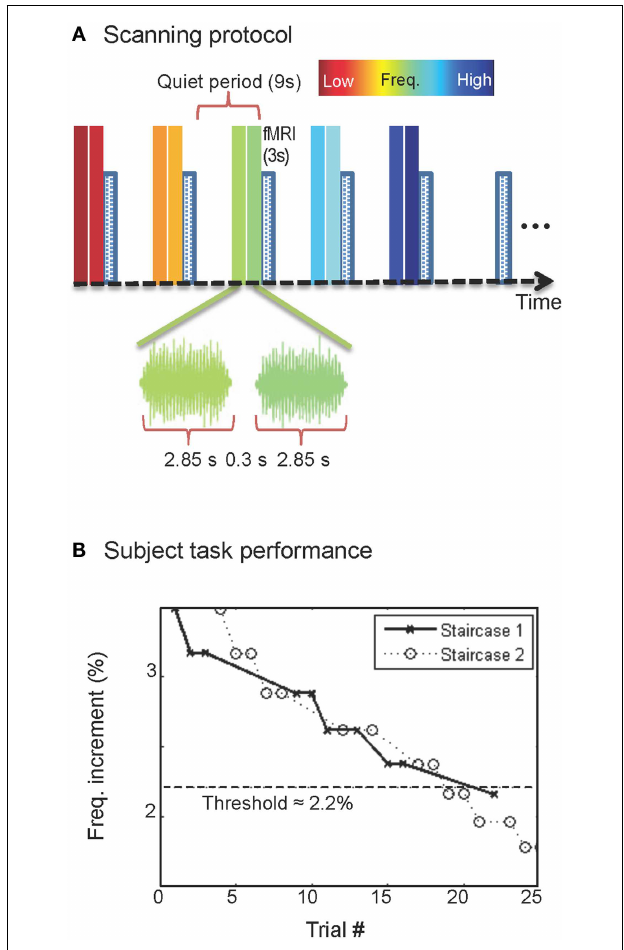
FIGURE 1 | Protocol, stimulus, and task . (A) Sequence of stimulus presentation and fMRI acquisition; sound frequency is color-coded. (B) Typical subject performance during a single fMRI